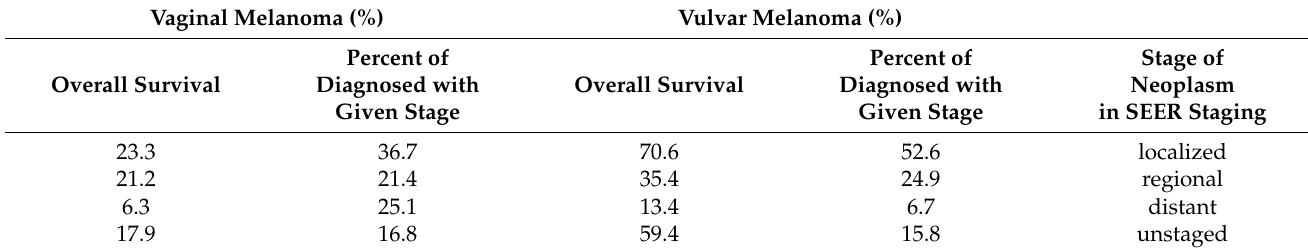
Table 2. Vulvar and vaginal melanoma; survival and diagnosis rate based on staging. Table designed and based on work of Wohlmuth et al.